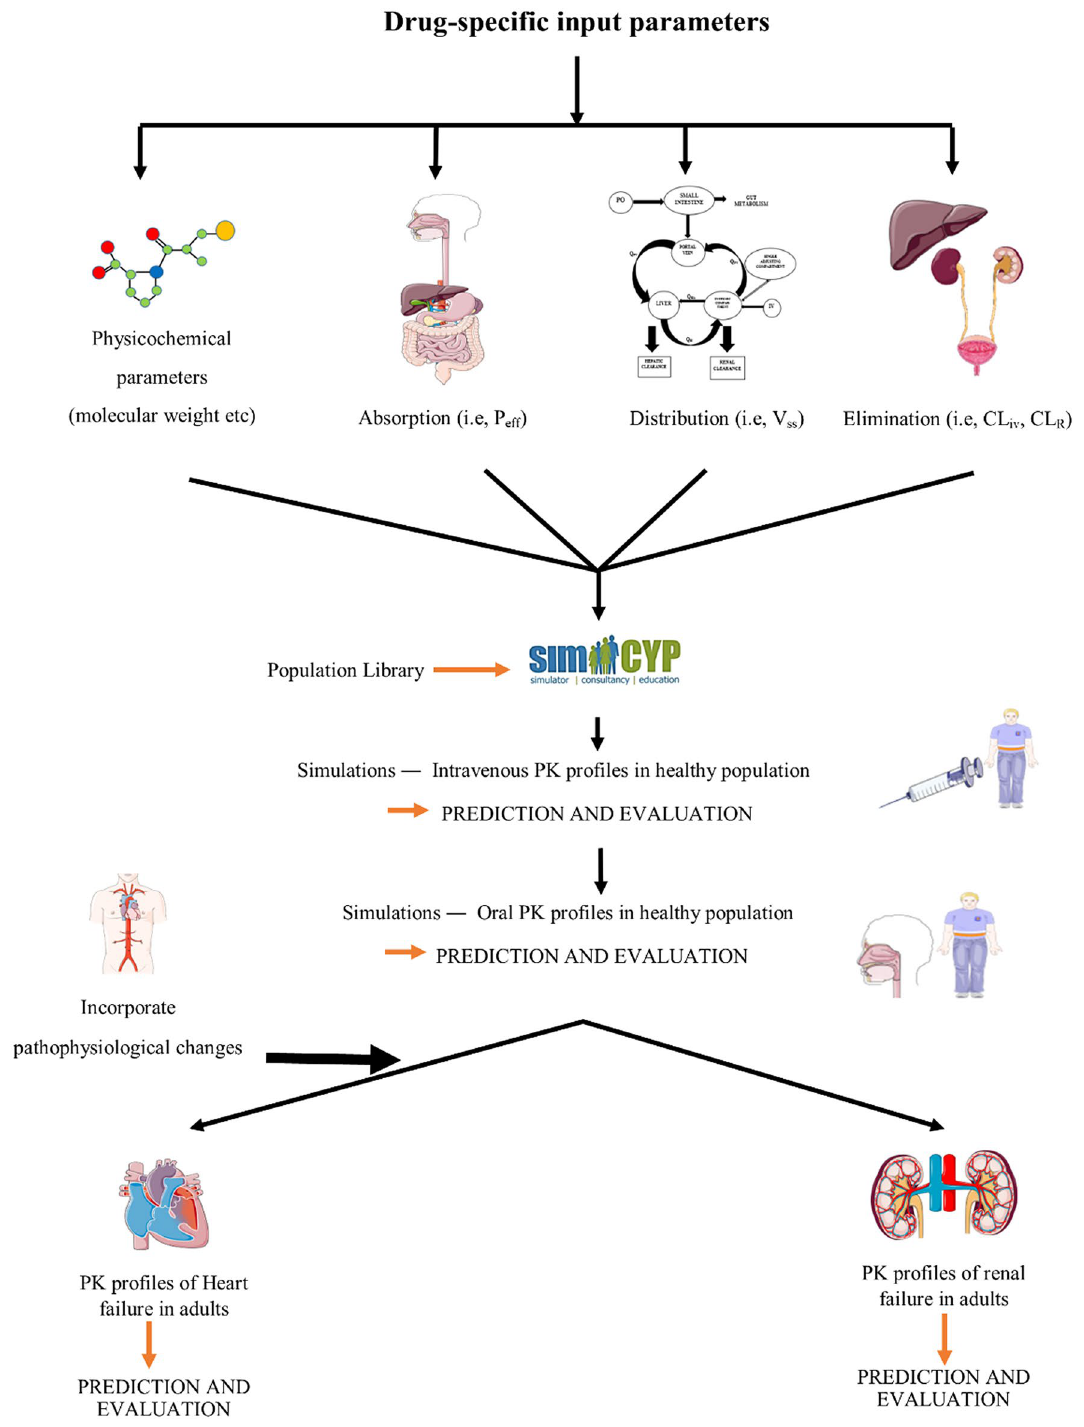
Figure 1. Systematic flow chart diagram for the developed captopril PBPK models in healthy and disease, populations. P eff : human jejunum permeability, V ss : volume of distribution at steady-state, CL iv : intravenous clearance, CL R : renal clearance, PK: